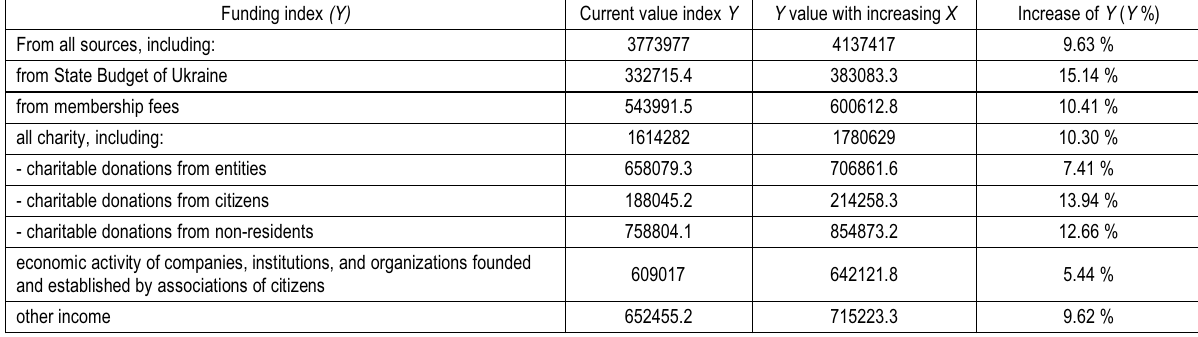
Table 10.The impact of the factor “Compensation of employees” on the sources of funding of